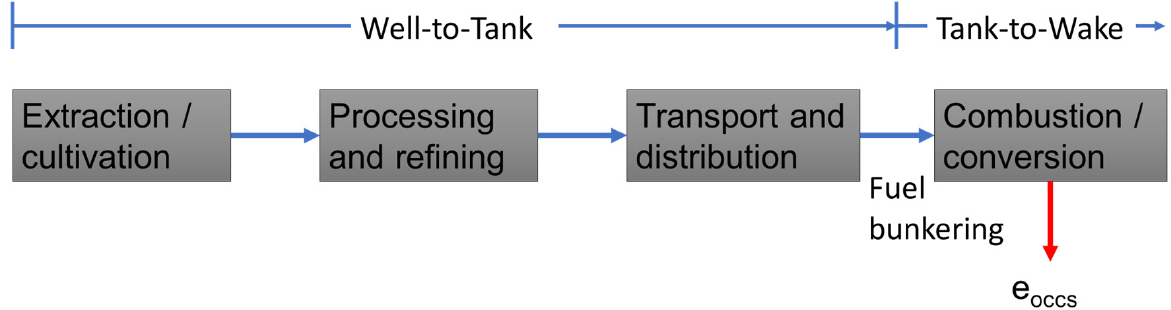
Figure 6. WtW supply chain, based on ISWG-GHG 11/2/3 paragraph 3.5 [44], but edited to include possible carbon capture and storage technologies.